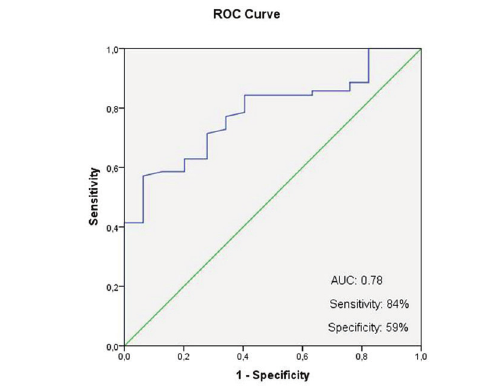
Figure 2 - Receiver operator characteristic curve of gamma- glutamyl transferase/albumin ratio to predict coronary slow flow